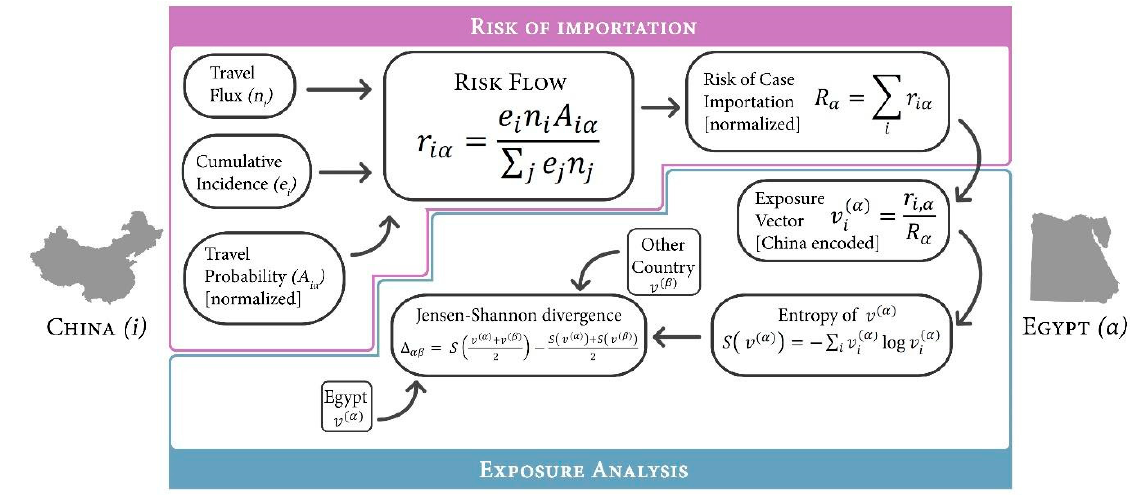
Figure 1. Adapted flow diagram of mathematical models used in determining the probability of exposure to imported coronavirus disease 2019 (COVID-19) from a city in China ( i ) to Egypt ( α ) [6].